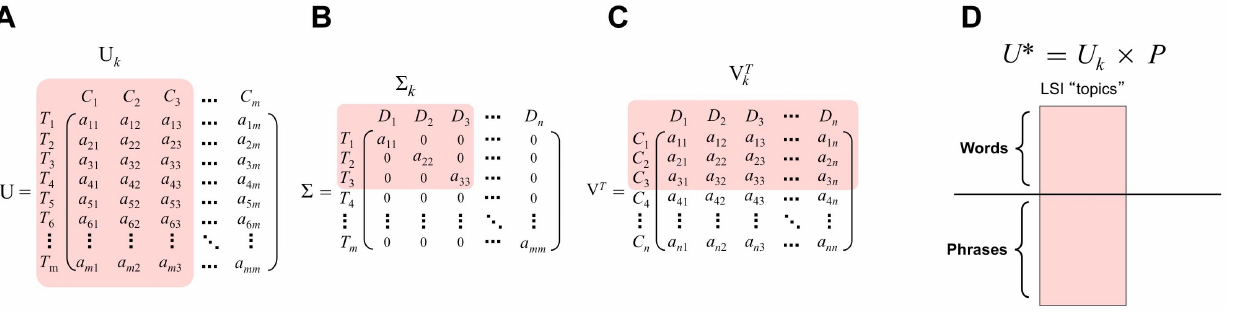
Figure 1. Singular Value Decomposition (SVD) on a term document matrix and the generation of the U* matrix. (A–C) U and V T contain the LSI vectors for terms and documents, respectively while S contains the singular values of the original term document matrix. (D) An illustration of the resulting matrix U*, obtained by the multiplication of U k and P. Note that the resulting matrix contains the word vectors and phrase vectors in LSI space, facilitating the comparison between every word/phrase and every other word/phrase entity.